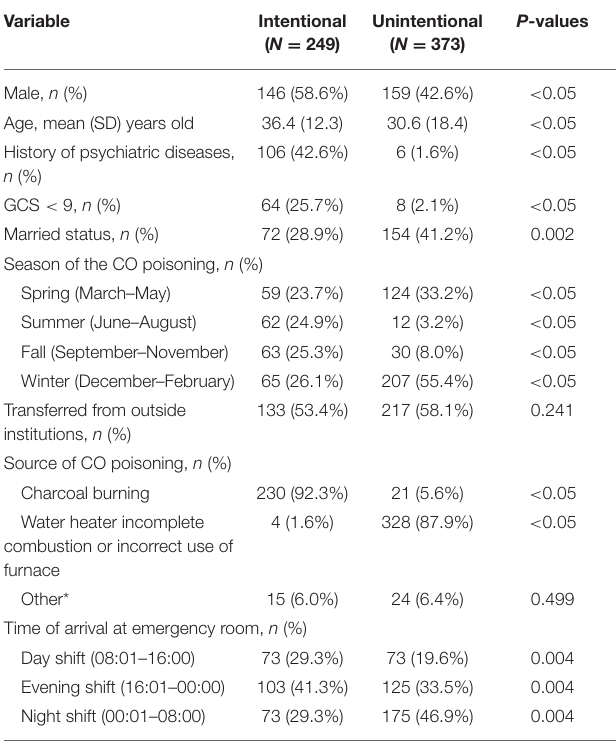
TABLE 1 | Demographics and clinical data of CO poisoning